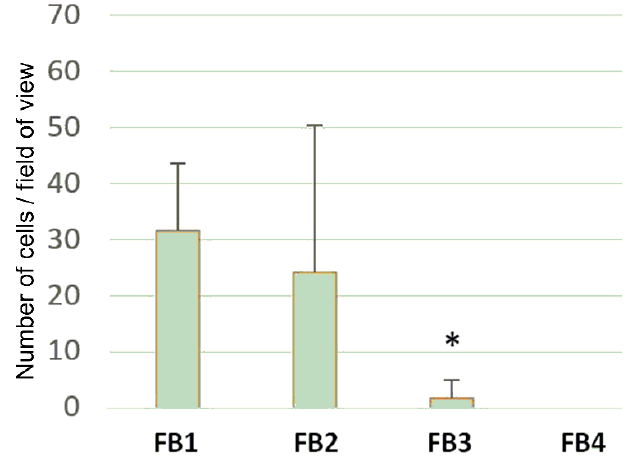
Figure 7. Evaluation of adhesive properties of polymer films FB1 – FB4 for UC MSCs (vertical scale—a number of cells in a field of view). * p < 0.05 in comparison with FB-1 .